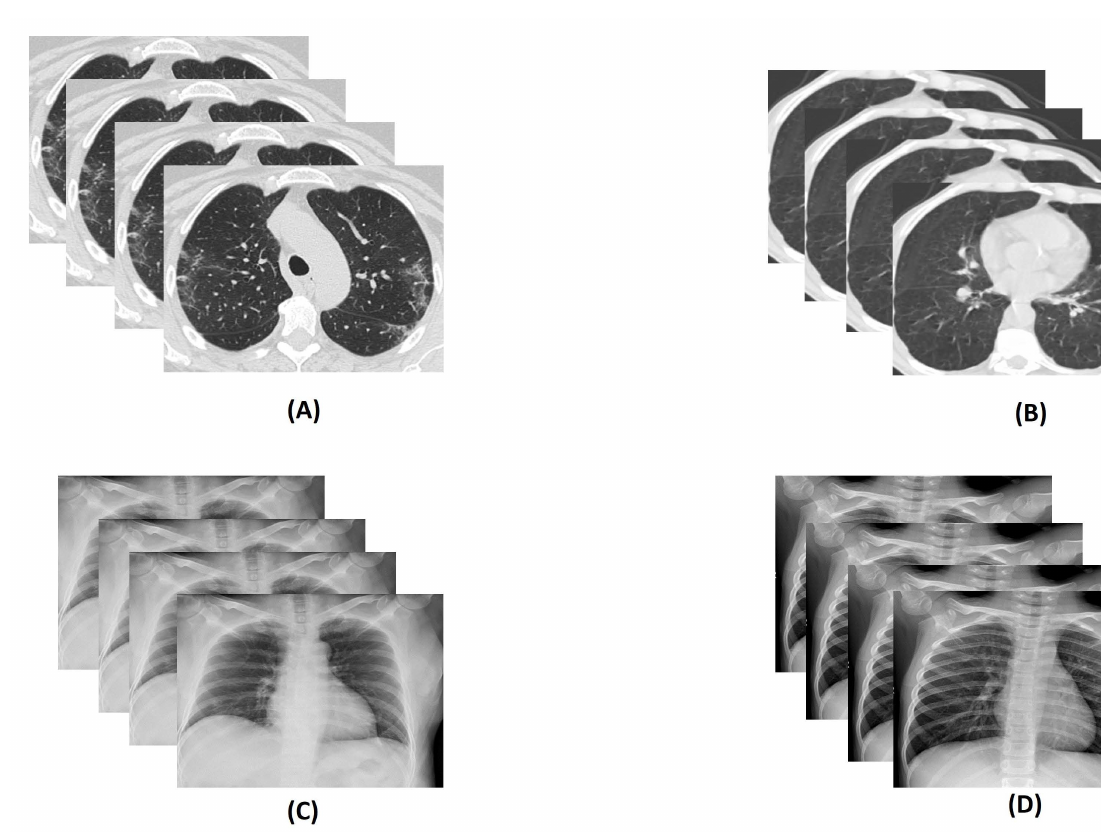
Figure 2. Illustration of sample: ( A ) COVID Computed Tomography (CT) scan images, ( B ) non-COVID CT scan images, ( C ) COVID X-ray images, and ( D ) non-COVID X-ray